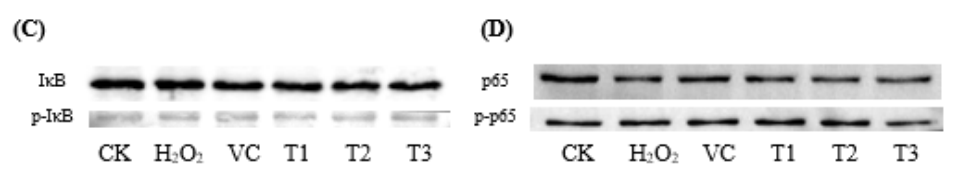
Figure 6. The effects of crude extract of Dioscorea alata L. on protein expression level of oxidative damage induced by H 2 O 2 in IPEC-J2 cells. It is mainly reflected by ( A ) I κ B/p-I κ B relative protein expression and ( B ) p65/p-p65 relative protein expression. The bands of western blot are shown in ( C , D ). Note: Compared with the blank control group, the difference was significant for different lowercase letters ( p < 0.05), the difference was extremely significant for different uppercase letters ( p < 0.01), and the difference was not significant for no letters or the same letter shoulder label ( p > 0.05). Blank control group: only DEME high glucose medium; Negative control group: DEME high glucose medium +120 µ mol/L H 2 O 2 ; Positive control group: DEME high glucose medium +120 µ mol/L H 2 O 2 + 50 µ g/mL VC; Group T1–3: DEME high glucose medium +120 µ mol/L H 2 O 2 + crude extracts of Dioscorea alata L. at different concentrations (25, 50 and 75 μg/mL).